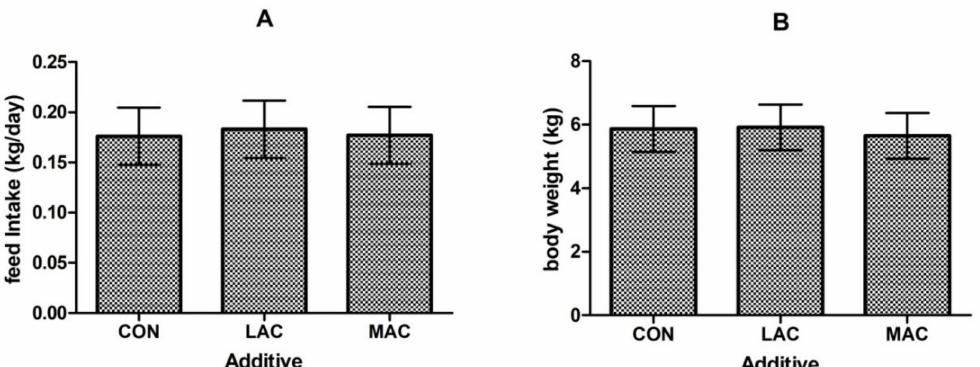
Figure 2. E ff ects of supplementing probiotics and prebiotics additives on feed intake ( A ) and body weight ( B ) of young goats (Exp. 2). CON = control group; LAC = a control diet supplementing with 10 g / day Lactobacillus plantarum P-8; MAC = a control diet supplementing with 0.3 g / day plant extract (Sangrovit ® , MAC extract 3.75% w / w